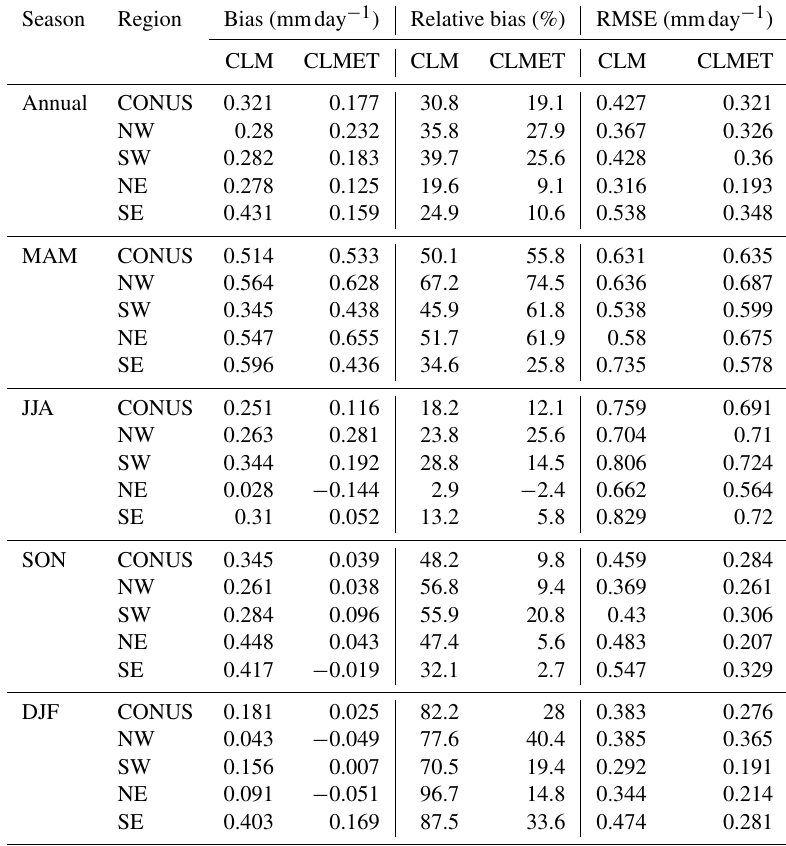
Table 2. Similar to Table 1, but based on comparison with MODIS-derived ET during the period